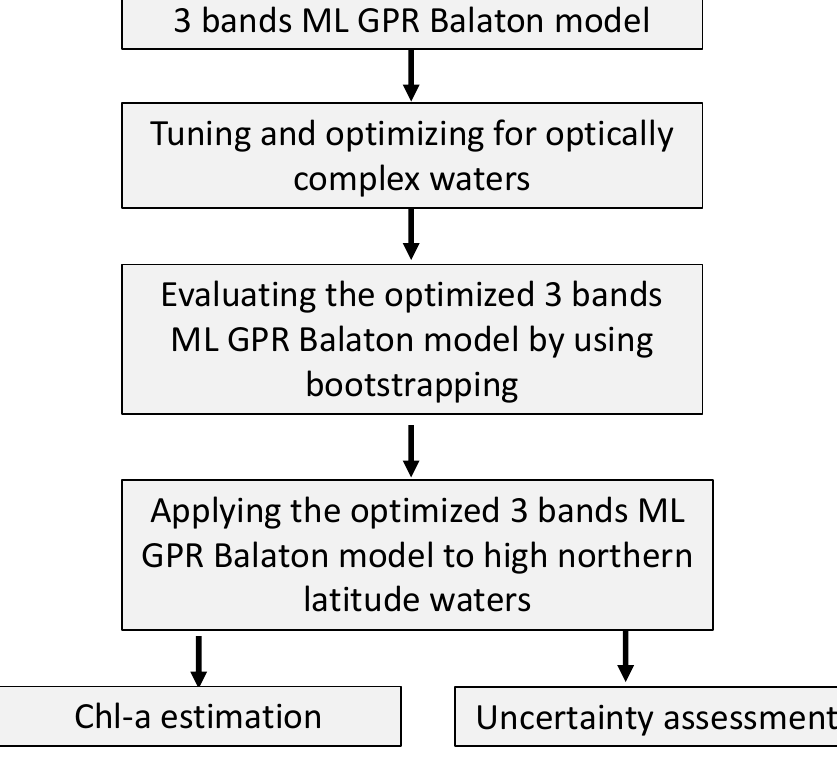
Figure 5. Flowchart of the